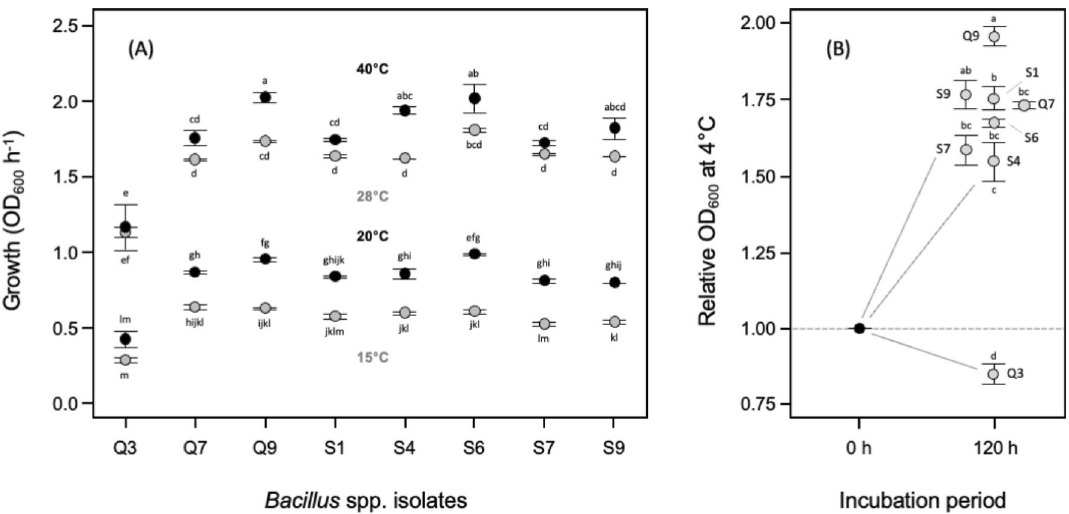
Figure 5. In KB. ( A ) Temperature response (15–40 °C/24 h) and ( B ) growth/survival at 4.5 °C/120 h). Means ± SE are shown on the y-axis and isolates on the x-axis. Means not connected by the same letter are significantly different (TK-HSD, α =